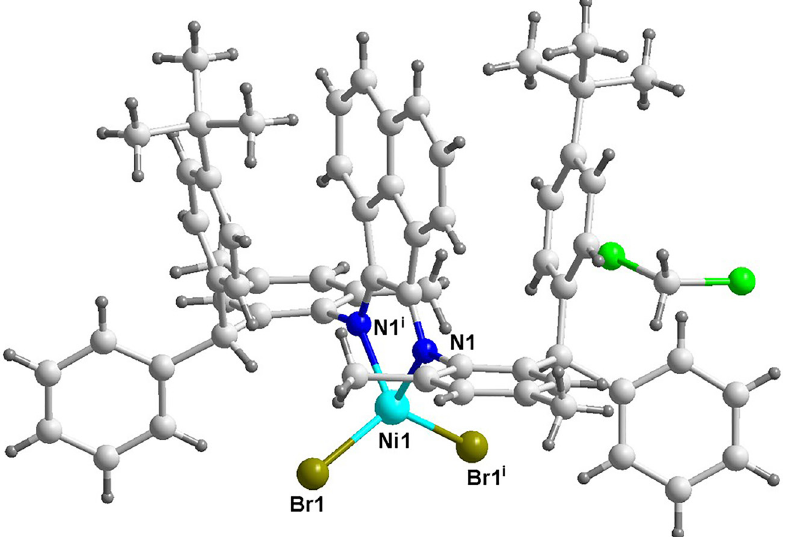
Table  : Data collection and handling.